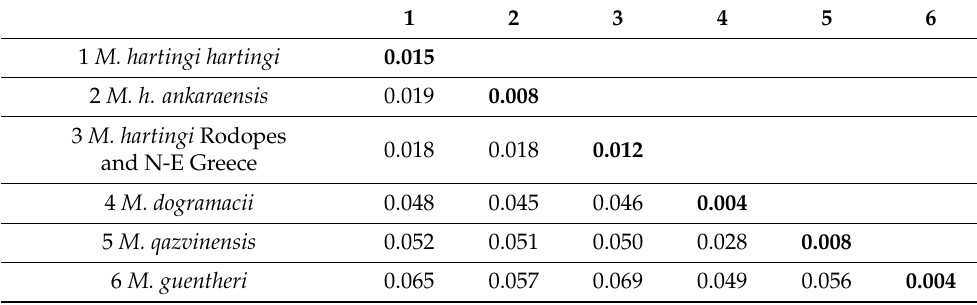
Table 4. p-Distances between intraspecific forms and species of the West “guentheri”